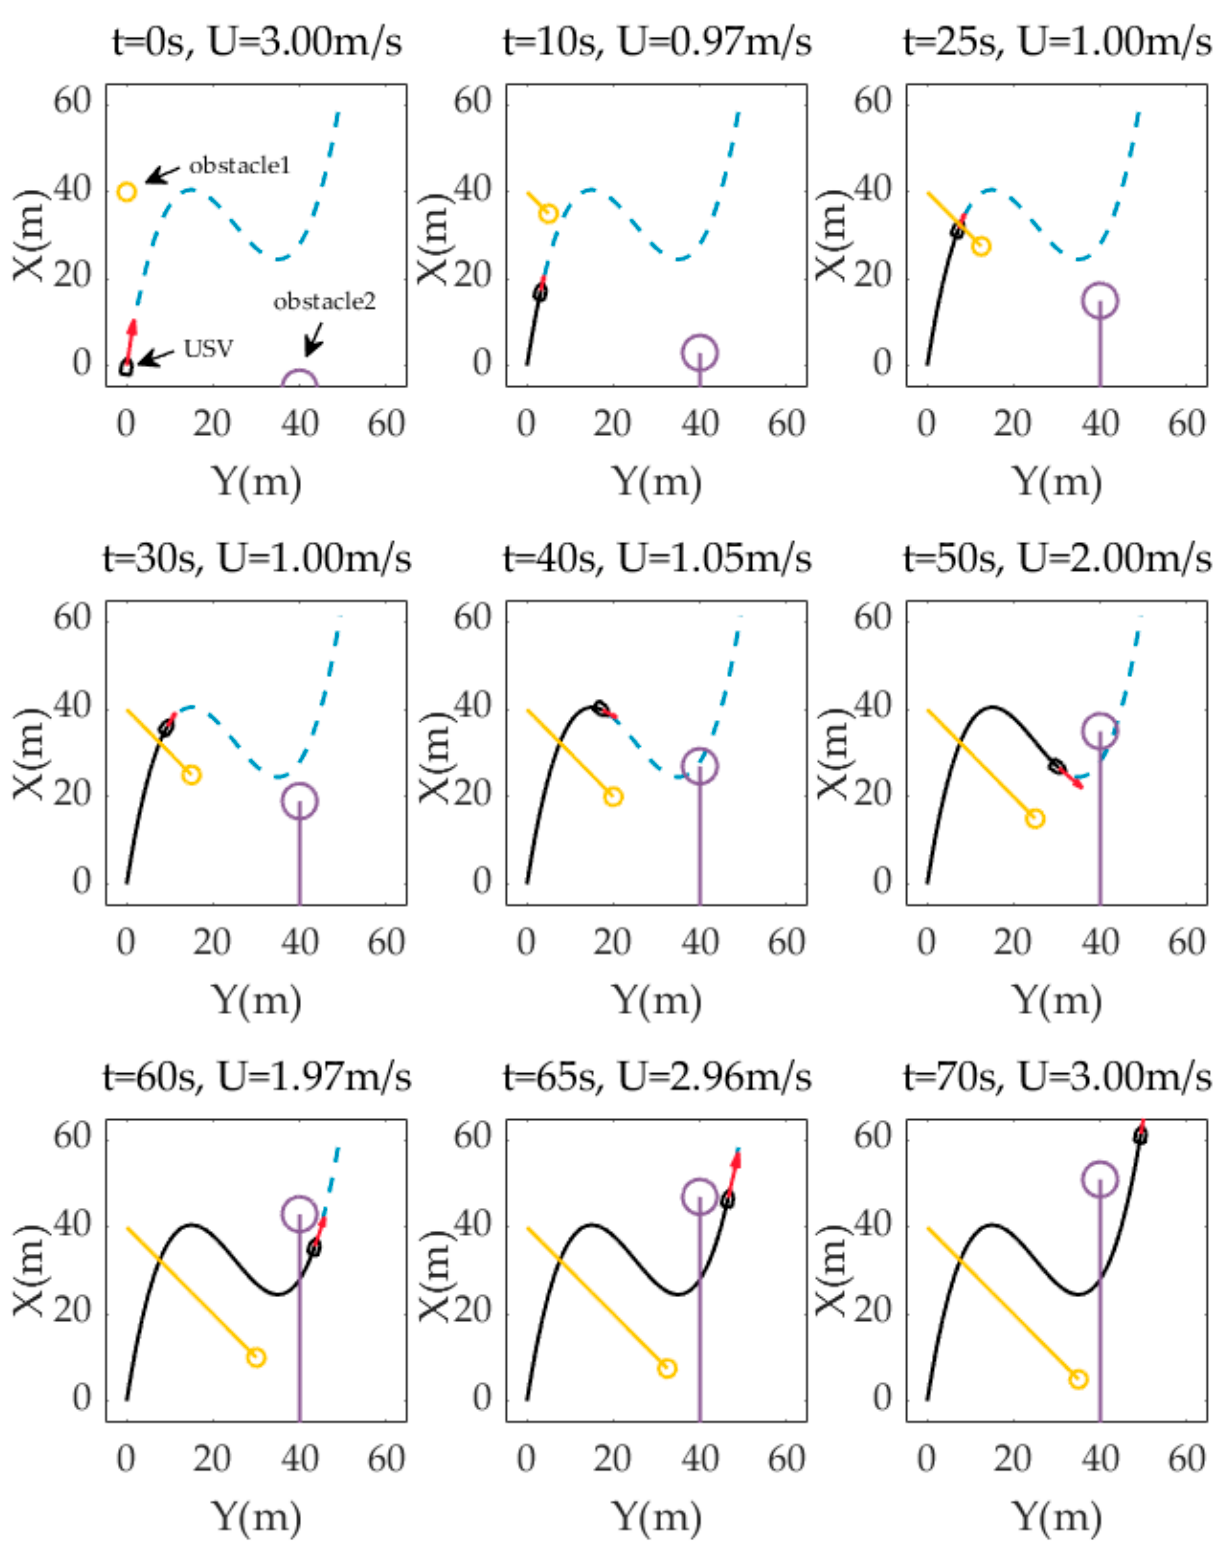
Figure 6. Time diagram of USV path following and dynamic obstacle avoidance.